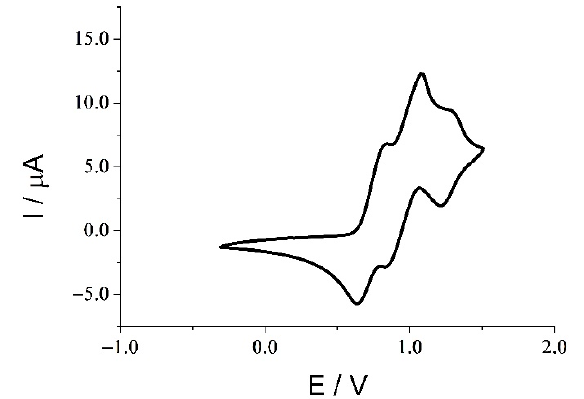
Figure 2. Cyclic voltammogram of 3 in THF.